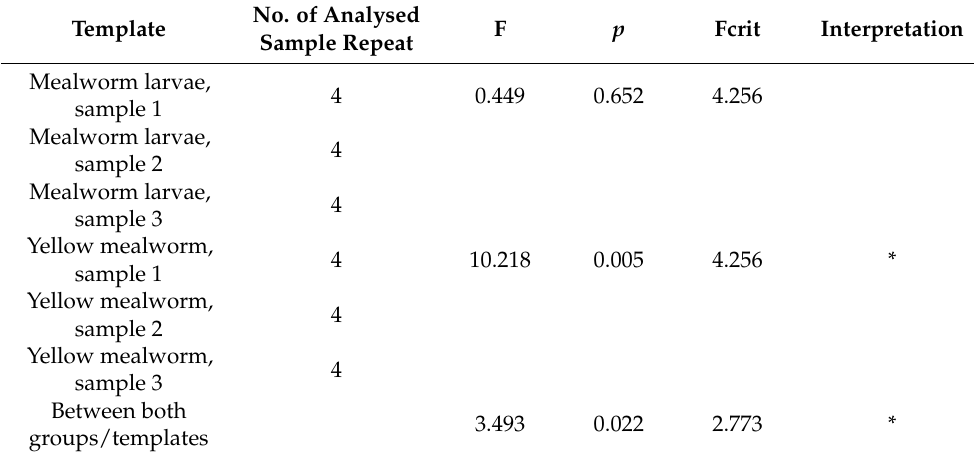
Table 5. One-way analysis of variance for both forms of yellow mealworm (larva and adult